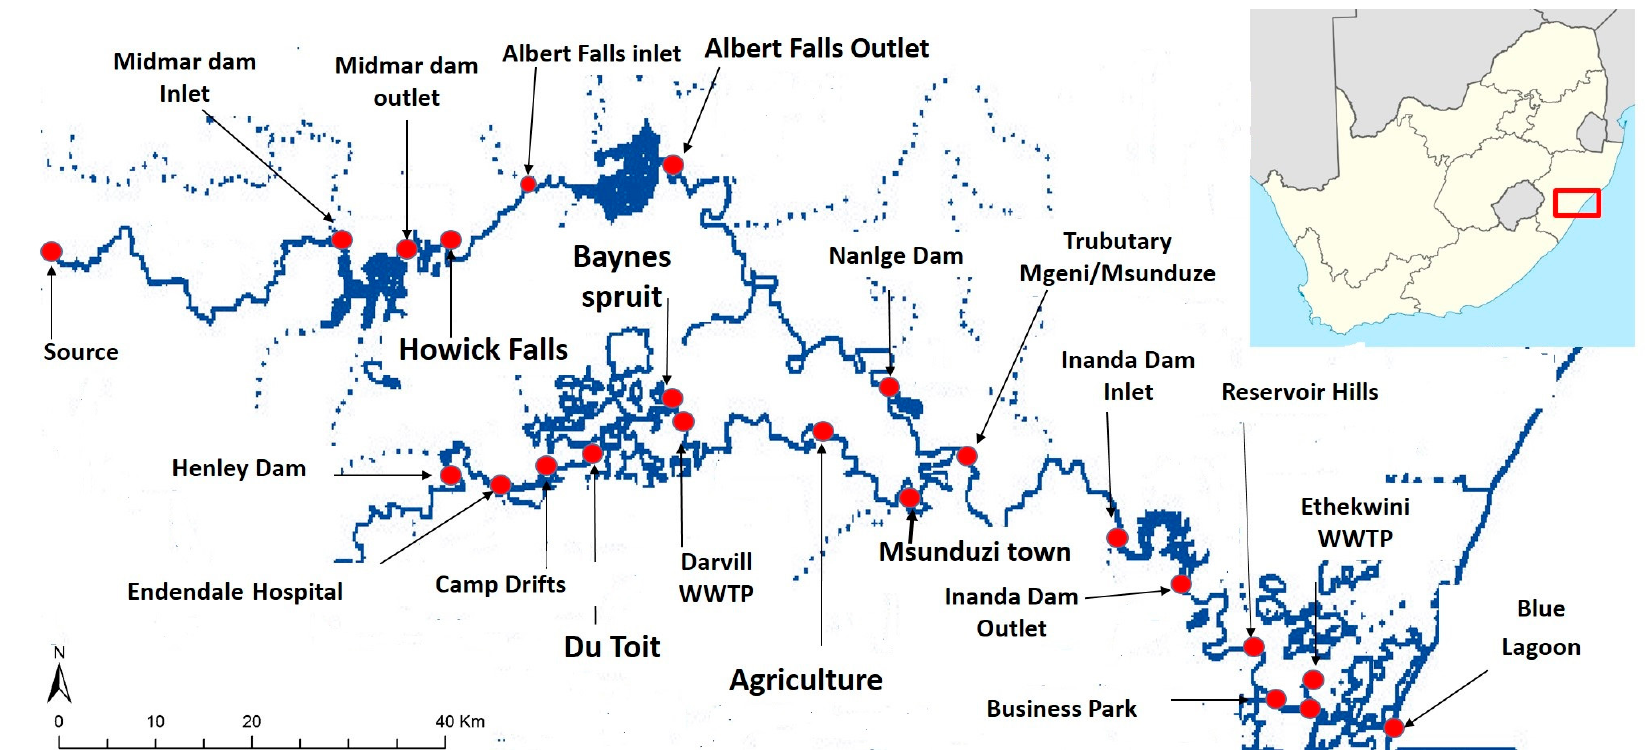
Figure 1. Sampling area of the Msunduzi and Mgeni Rivers in KwaZulu-Natal, South Africa. Grab samples were collected along all points indicated and analyzed using the developed method described in this work (map was drawn using GIS software (Caliper Corporation, Newton MA, United States of America) shape file).